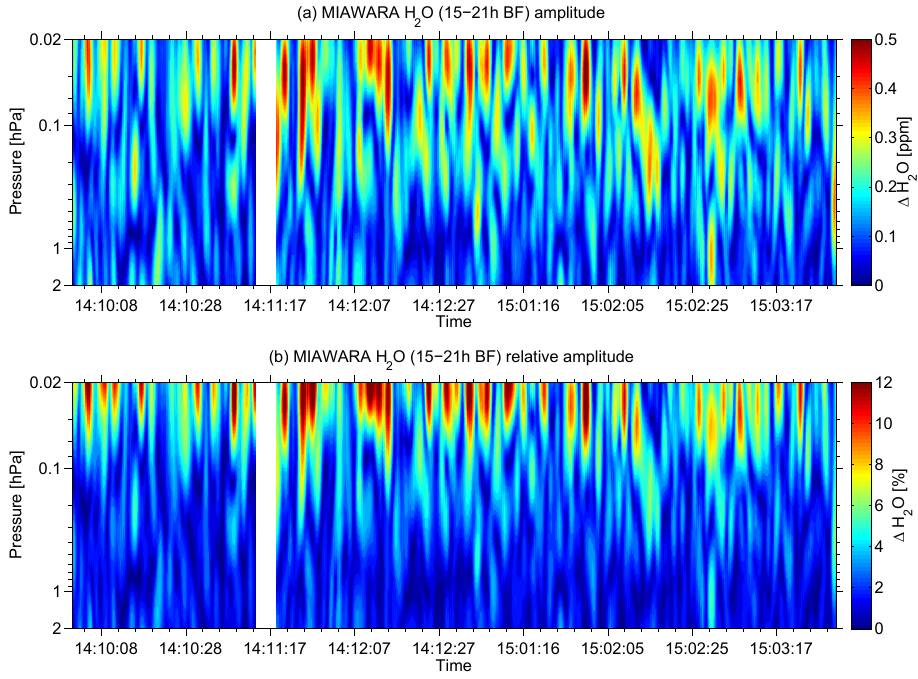
Figure 7. Temporal evolution of wave amplitudes derived from band-pass Hamming-window-filtered MIAWARA H 2 O volume mixing ratio time series with cutoff periods at 15 and 21h. Shown is the time period from October 2014 to March